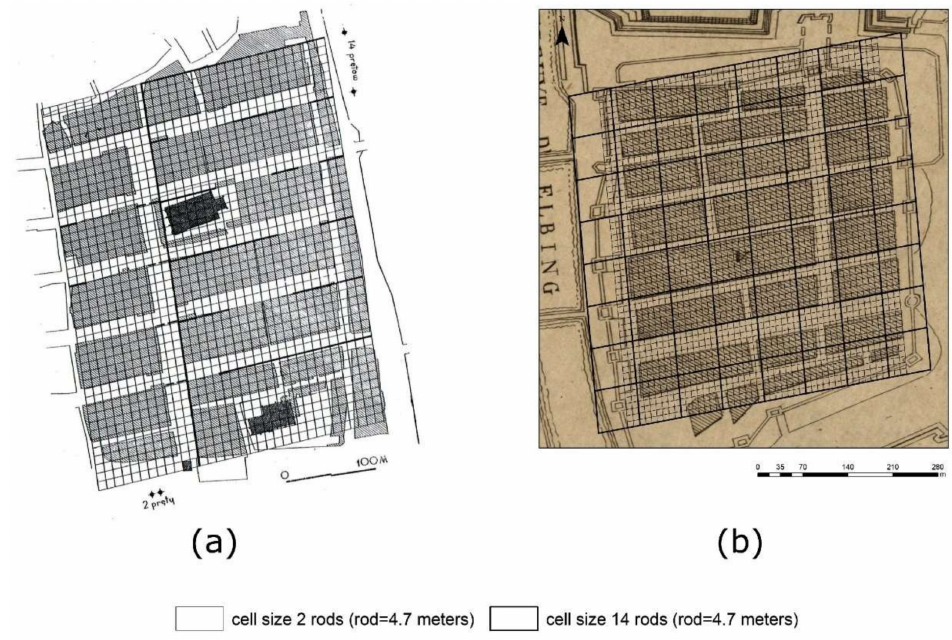
Figure 9. Comparison of the research results conducted using traditional method ( a ) [71] and HGIS tools, example of Plan de la Ville d’Elbing (Town plan) ( b ).